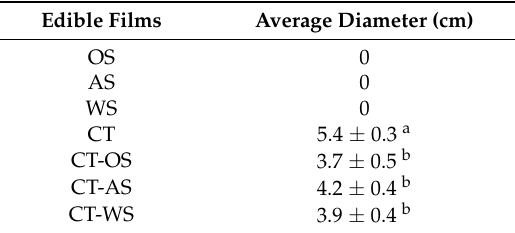
Table 4. Inhibitory effect of EF against Listeria innocua .